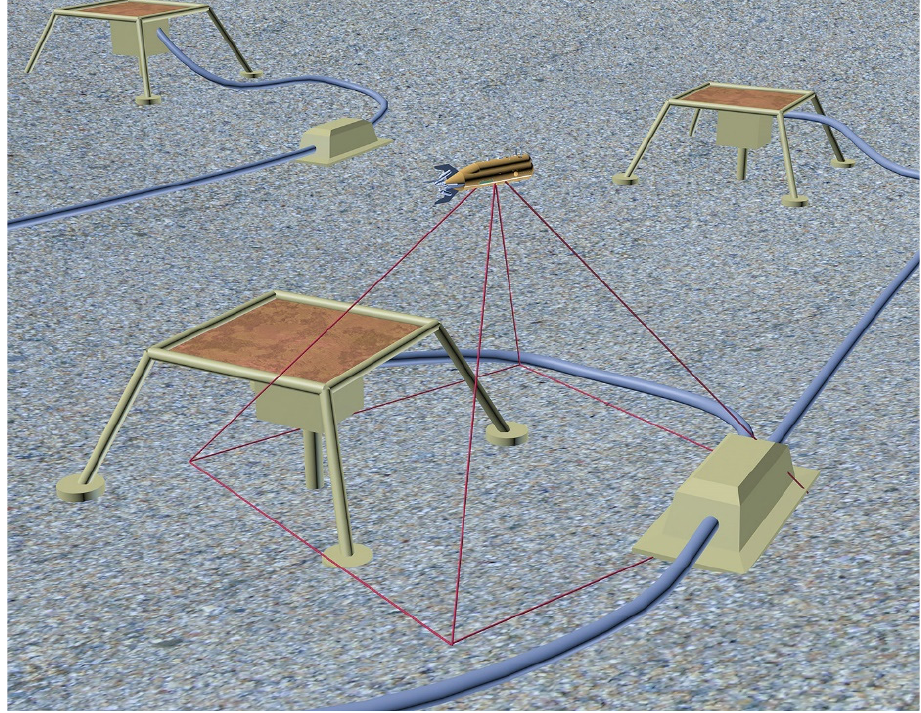
Figure 8. A virtual subsea scene with SPS.